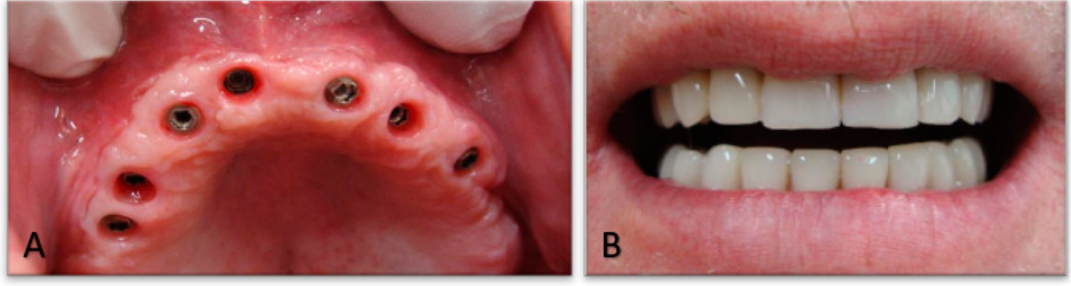
Figure 10. ( A ) Soft tissue, ( B ) final prosthesis placement.